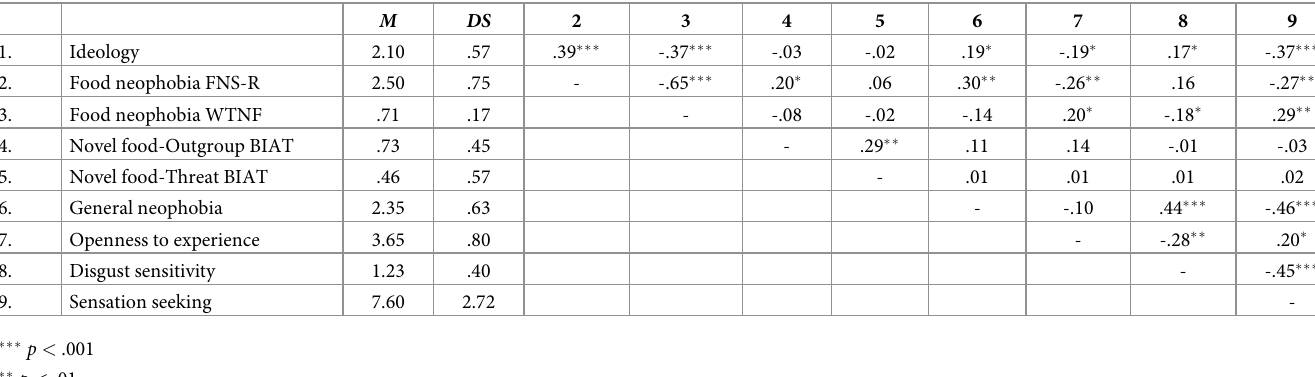
Table 3. Descriptives and correlations for Study 2